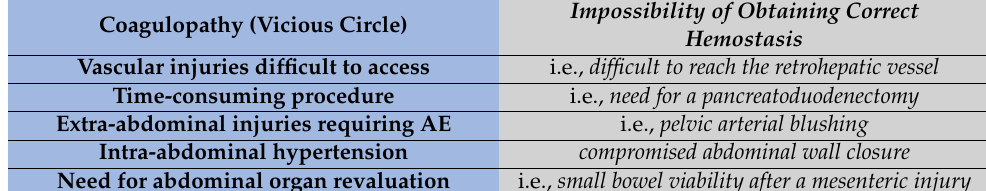
Table 1. Six reasons to perform abbreviated laparotomy [15]. Coagulopathy (Vicious